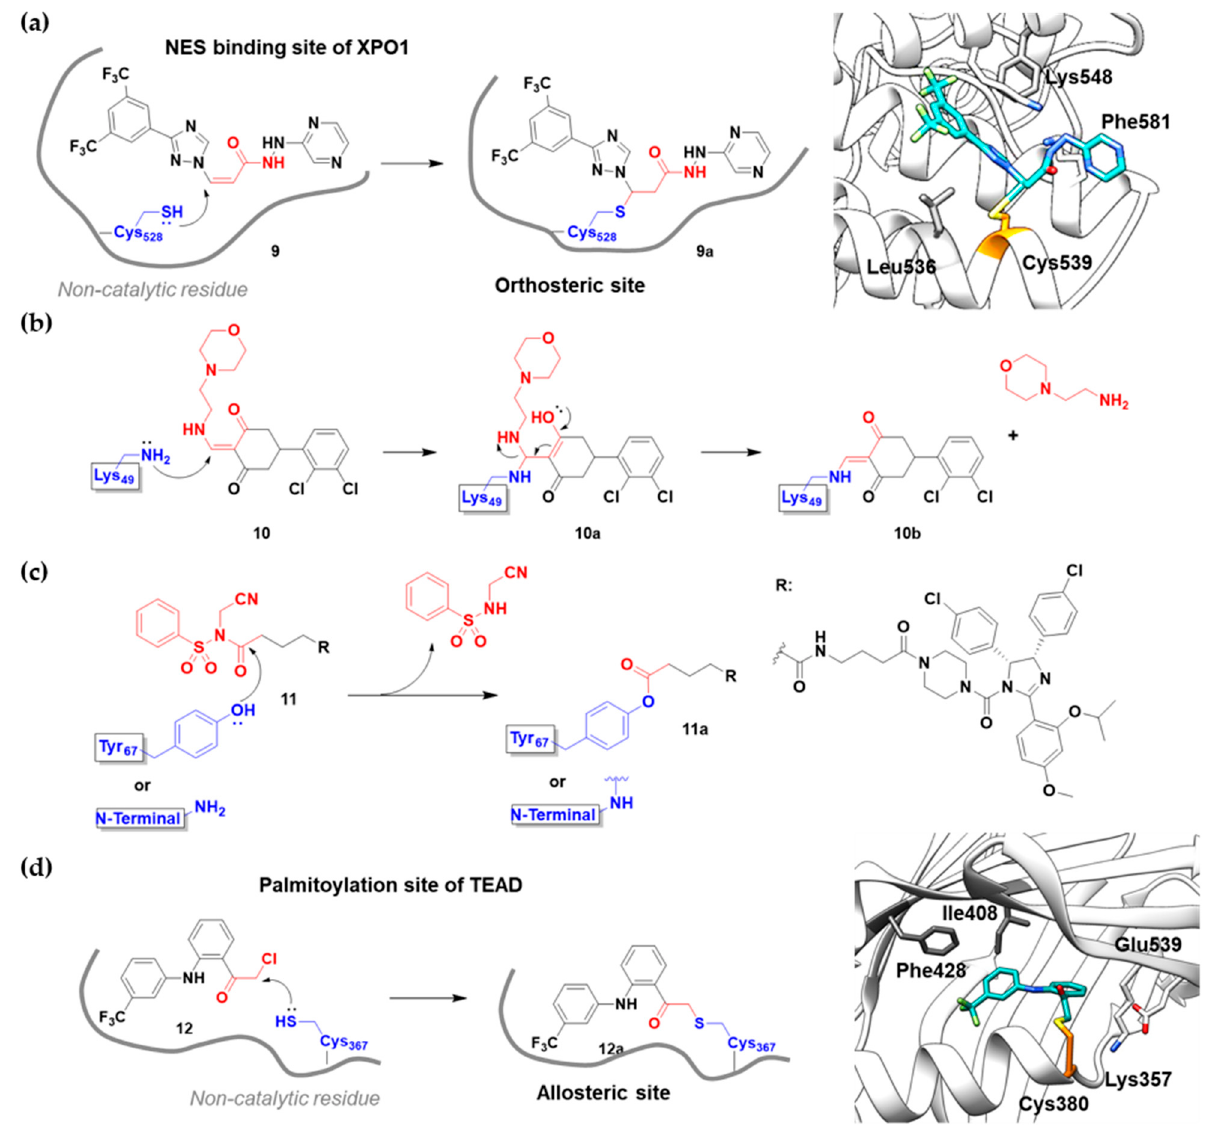
Figure 5. Representative examples of “expanded” targeted covalent inhibitors: ( a ) schematic diagram and co-crystal structure of exportin 1 (XPO1) with covalent inhibitor 9 (selinexor) (PDB: 7L5E). Selinexor is bound to the non-catalytic cysteine residue at the PPI interface. Mechanism of the reaction between cysteine and acryloyl hydrazide warhead of selinexor generating β -thiopropane hydrazide adduct 9a is shown; ( b ) mechanism of the reaction between lysine and enaminone warhead of the covalent inhibitor 10 generating enaminone adduct 10a ; ( c ) mechanism of the reaction between tyrosine or N -terminal α -amine and NASA warhead of the covalent inhibitor 11 generating ester or amide adduct 11a ; ( d ) schematic diagram and co-crystal structure of TEAD with covalent inhibitor 12 (PDB: 6E5G). 12 is bound to the non-catalytic residue at the allosteric site of PPI. Mechanism of the reaction between cysteine and α -chloromethyl ketone generating α -thiomethyl ketone adduct 12a is